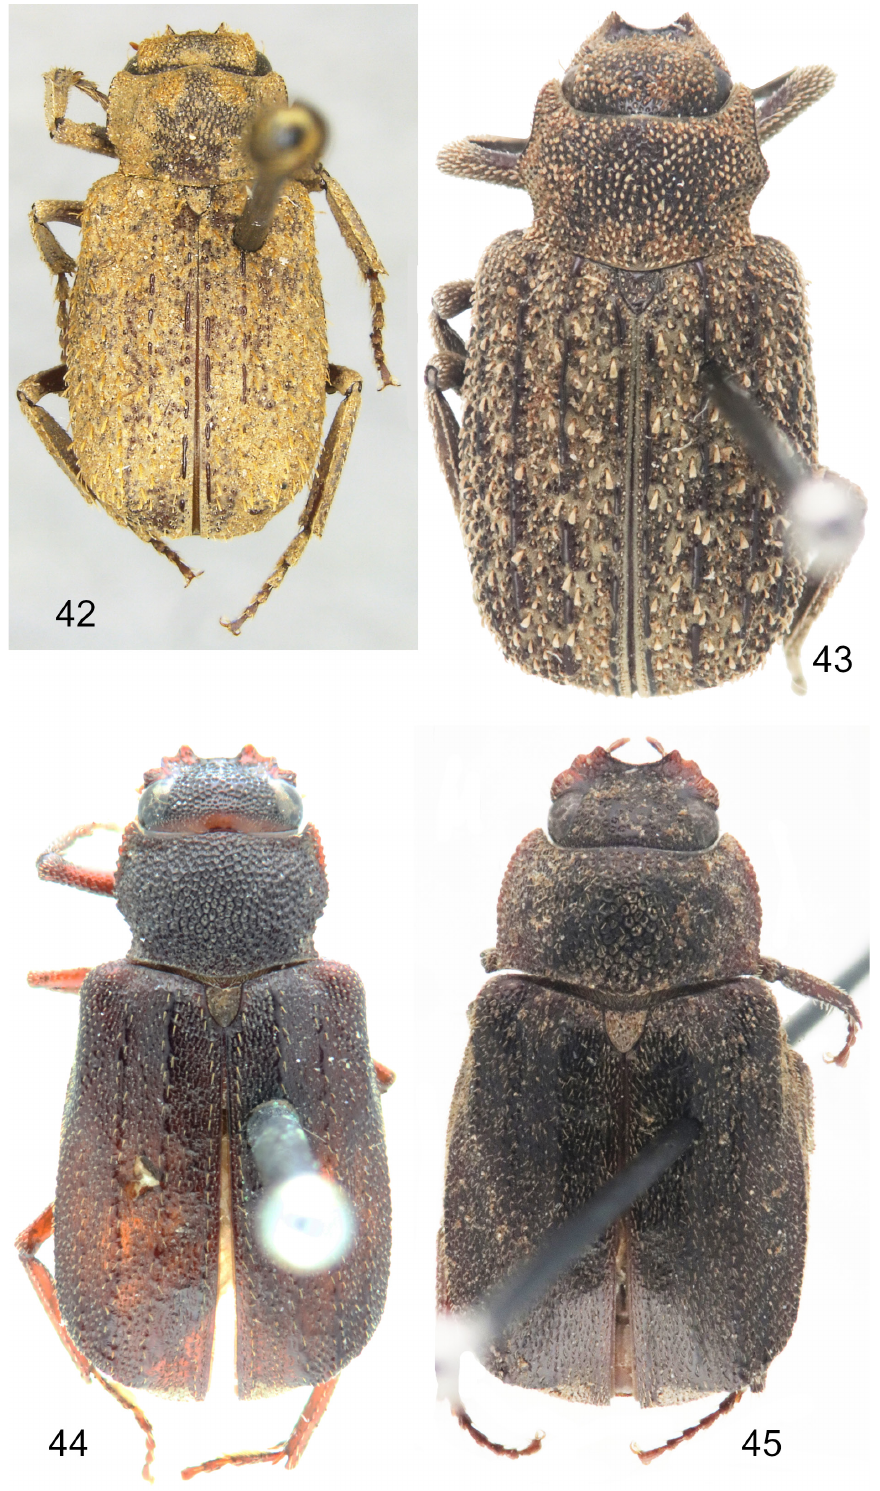
Figs 42–45. Papuan Maechidius Macleay, 1819, habitus, dorsal view. 42 . M. heterosquamosus Heller, 1910 comb. rest., lectotype, ♀ (SNSD). 43 . Same, ♂, holotype of M. clypeatus (Frey, 1969) comb. nov. (BPBM). 44 . M. hirtipes Arrow, 1941, lectotype, ♂ (BMNH). 45 . M. humeralis Heller, 1914, lectotype, ♂ (SNSD). Not to